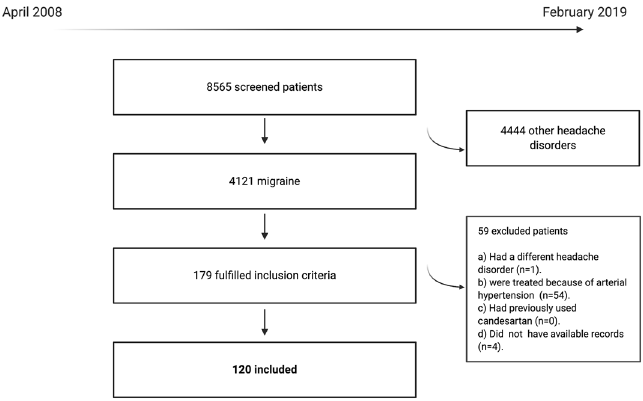
Figure 1. Flow-diagram of screened, included, and excluded